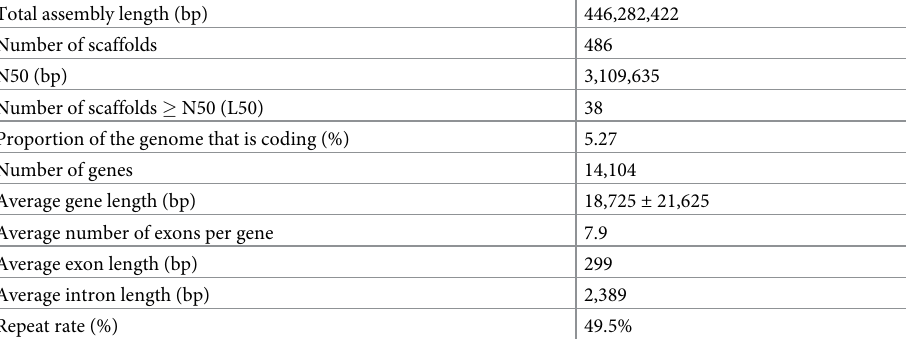
Table 2. Assembly and gene prediction metrics of S . bovis from